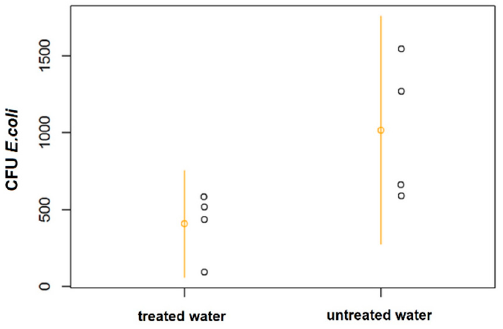
Figure 8. CFU of Escherichia coli per gram of plant tissue, dotplot with means and 95% confidence intervals. Each point represents the average of four samples per plot grouped as a single experimental unit.